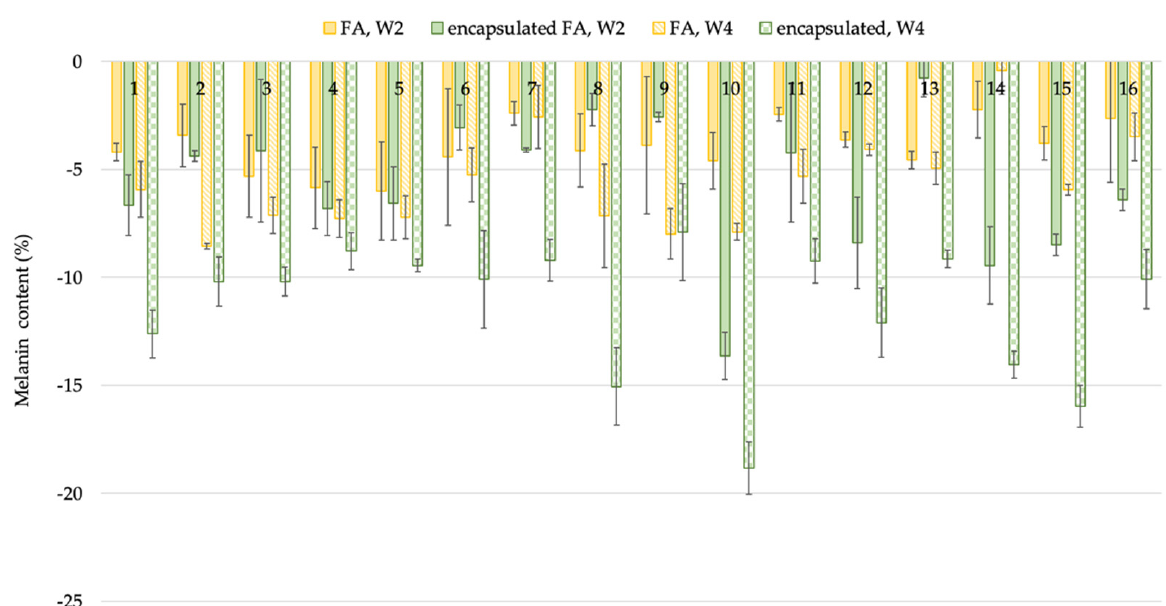
Figure 10. Percent of change in skin elasticity (R2) of each volunteer after application of FA and encapsulated FA creams after 2 and 4 weeks.